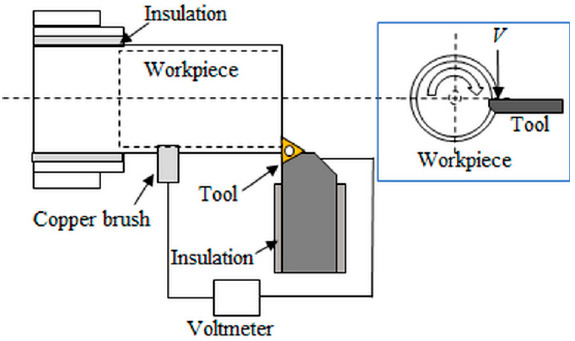
Figure 4. Schematic drawing of the temperature measurement using a tool–work thermocouple technique [38]. To enforce orthogonal cutting, a tubular workpiece with uniform wall thickness was used [39]. The cutting force was in the tangential direction of the tubular workpiece, and perpendicular to the tool’s cutting edge, as shown in the side-view drawing (blue